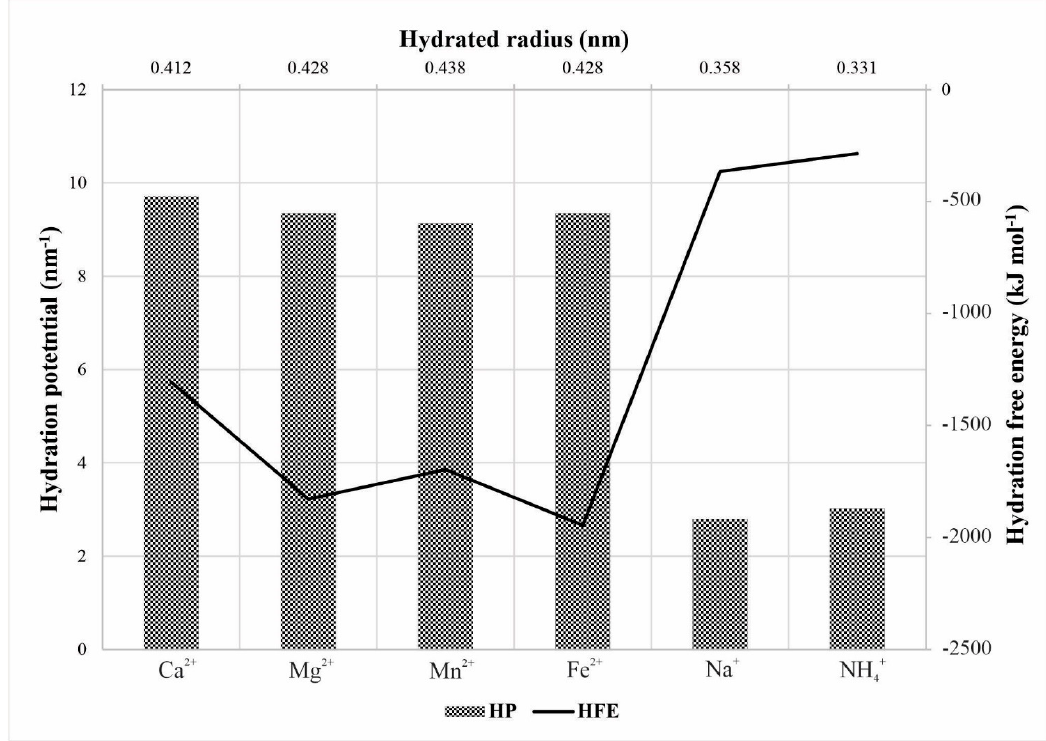
Figure 2. Selected hydration parameters of the investigated cations. The hydrated cations charge density (CD) plays significant role in the size exclusion mechanism [31]. CD is defined as the electric charge per unit volume of the hydrated ion and indicates the charge distribution over the ion volume. Stokes radii (r S ), Ionic radii (r i ) and charge densities of the investigated cations are presented in Table 4. CD values in C mm − 3 were calculated according to the Equation (11): where n ic represents the ion charge, the ionic radii are the Shannon-Prewitt values in mil- limeters [44], and e is the electron charge (1.60 × 10 − 19 C). Table 4. Stokes and Ionic radii and charge densities of the investigated ions.